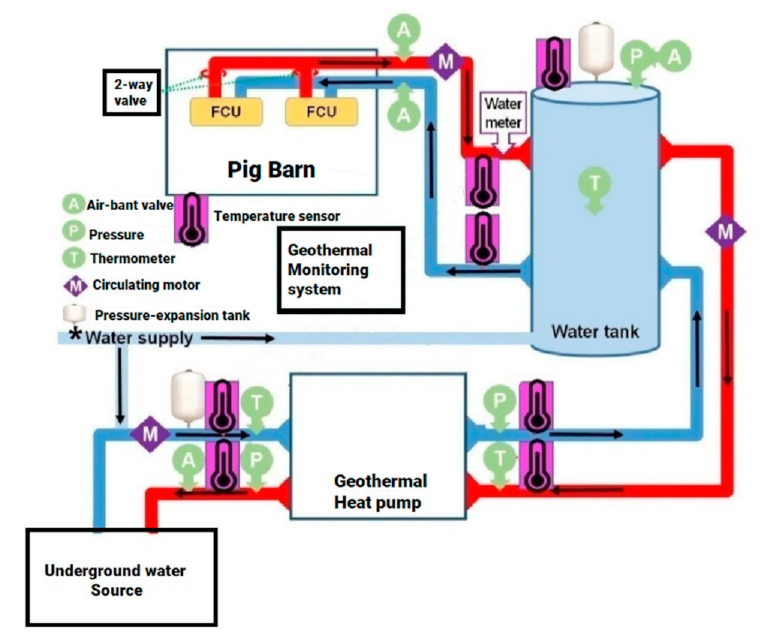
Figure 2. Schematic view of the geothermal heat pump and geothermal monitoring system. The red coloured pipes show hot water and the blue colour shows cold water. * Emergency water supply.